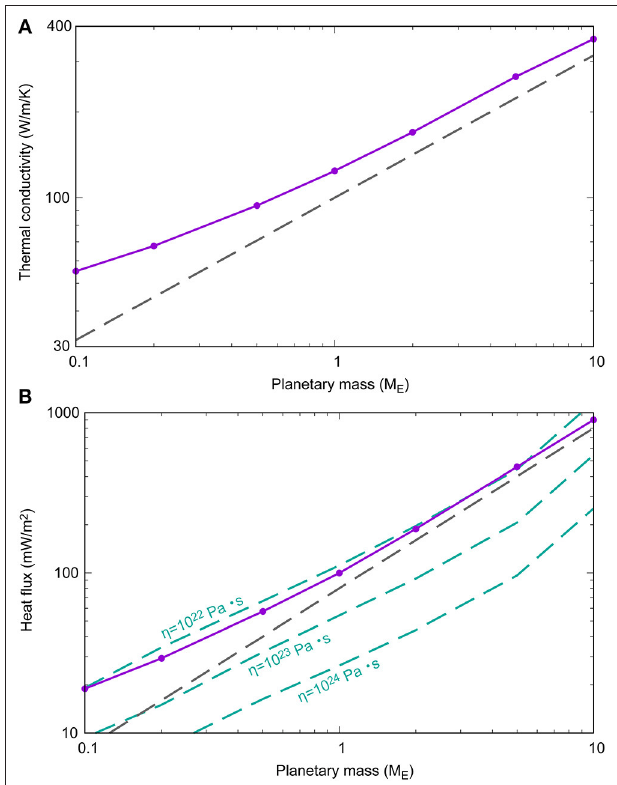
FIGURE 11 | (A) Thermal conductivity of terrestrial planets at the top of the core as functions of planetary mass normalized to the Earth’s mass ( M E ). Purple line with circles indicates present estimate. Gray broken line represents previous scaling ( Stixrude, 2014). (B) The heat flux at the CMB as a function of planetary mass. Purple solid line with circles indicates conductive heat flux along the isentropic temperature gradient at the top of the core. Green broken lines indicate the calculated heat flux across the thermal boundary layer (TBL) at the bottom of the mantle with assumed viscosity (see text). Gray broken line shows the previous estimate of the heat flux across the TBL ( Stixrude,